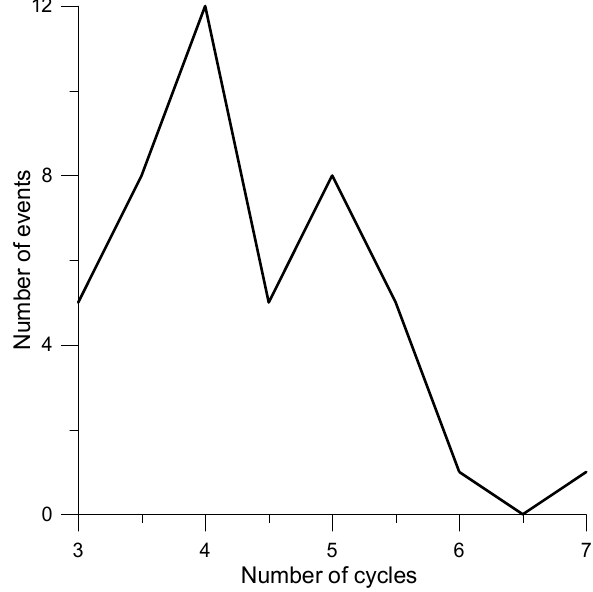
Fig. 7. Spectral distribution of the duration of the planetary wave type oscillation events (= persistence) in terms of number of cycles for the 5-day wave, station Juliusruh,